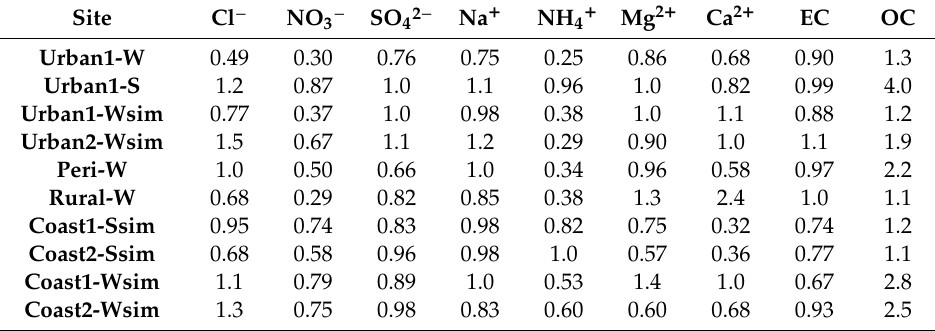
Table 9. Average indoor-to-outdoor concentration ratios calculated for ions, organic carbon (OC) and elemental carbon